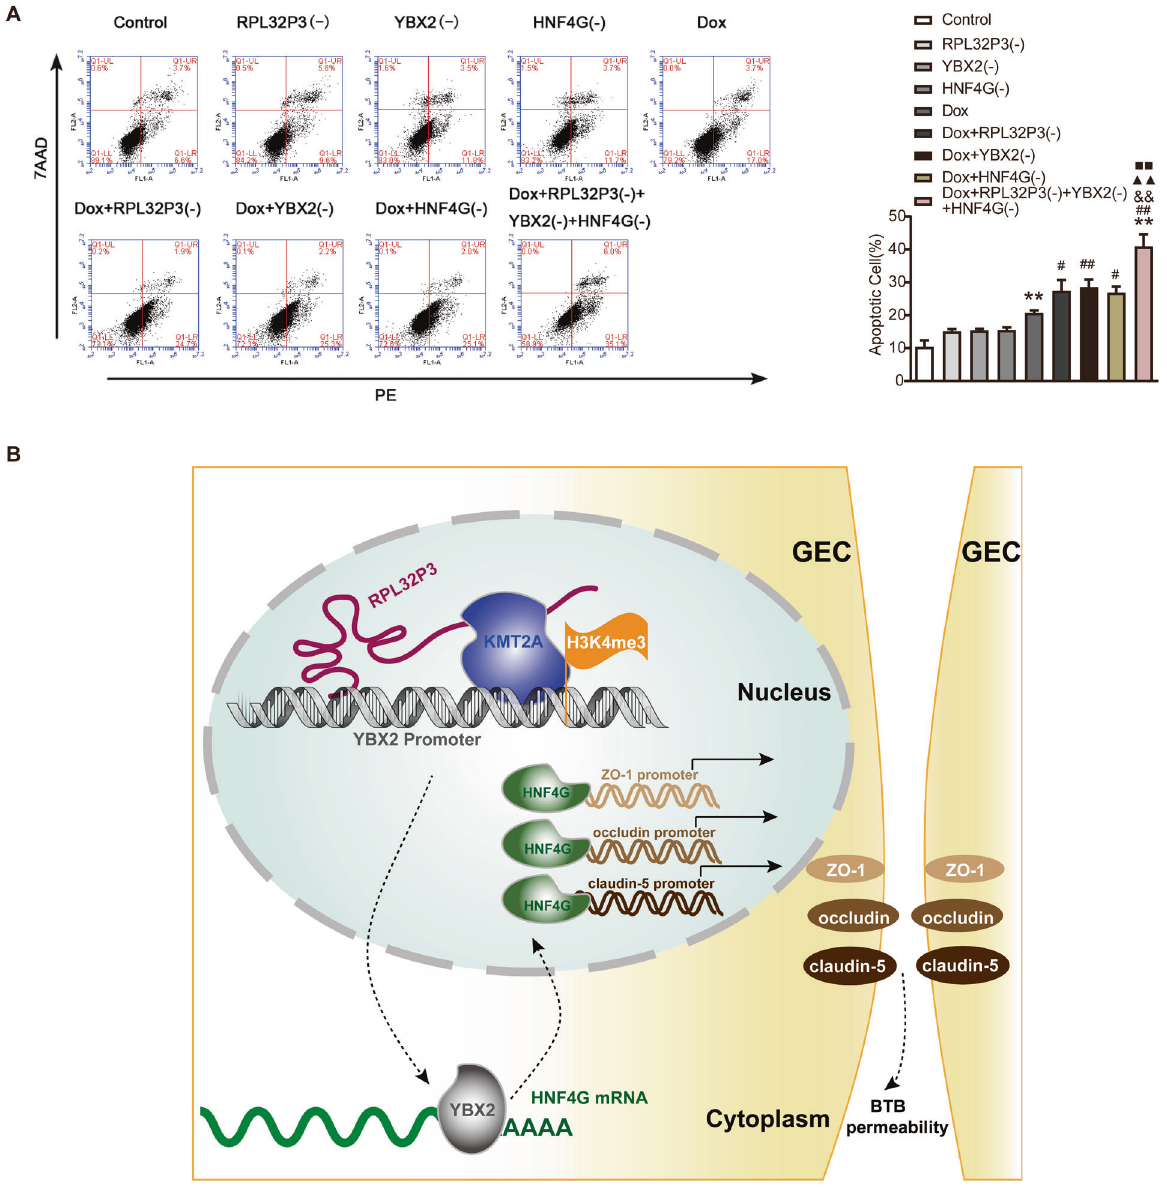
Fig. 8 Combined knockdown of RPL32P3, YBX2, and HNF4G increased the effect of doxorubicin (DOX) in promoting apoptosis of U251 cells. A Single or combined use of RPL32P3 knockdown, YBX2 knockdown and HNF4G knockdown increased the promoting effect of DOX on the apoptosis rate of U251 cells. Data represent mean ± SD ( n = 3, each). ** P < 0.01 vs. Control group, # P < 0.05 vs. DOX group, ## P < 0.01 vs. DOX group, && P < 0.01 vs. DOX + RPL32P3(-) group, ▲▲ P < 0.01 vs. DOX + YBX2(-) group, ■■ P < 0.01 vs. DOX + HNF4G(-) group. B The schematic diagram about the regulating process of RPL32P3/YBX2/HNF4G axis on BTB